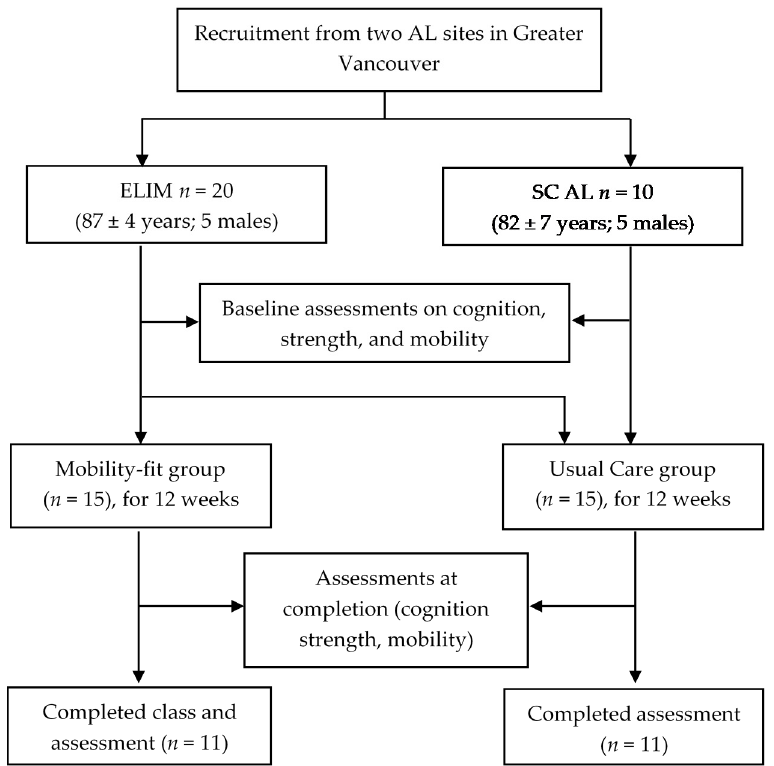
Figure 1. Flowchart of group allocations for the Mobility-Fit and Usual Care groups in this study.